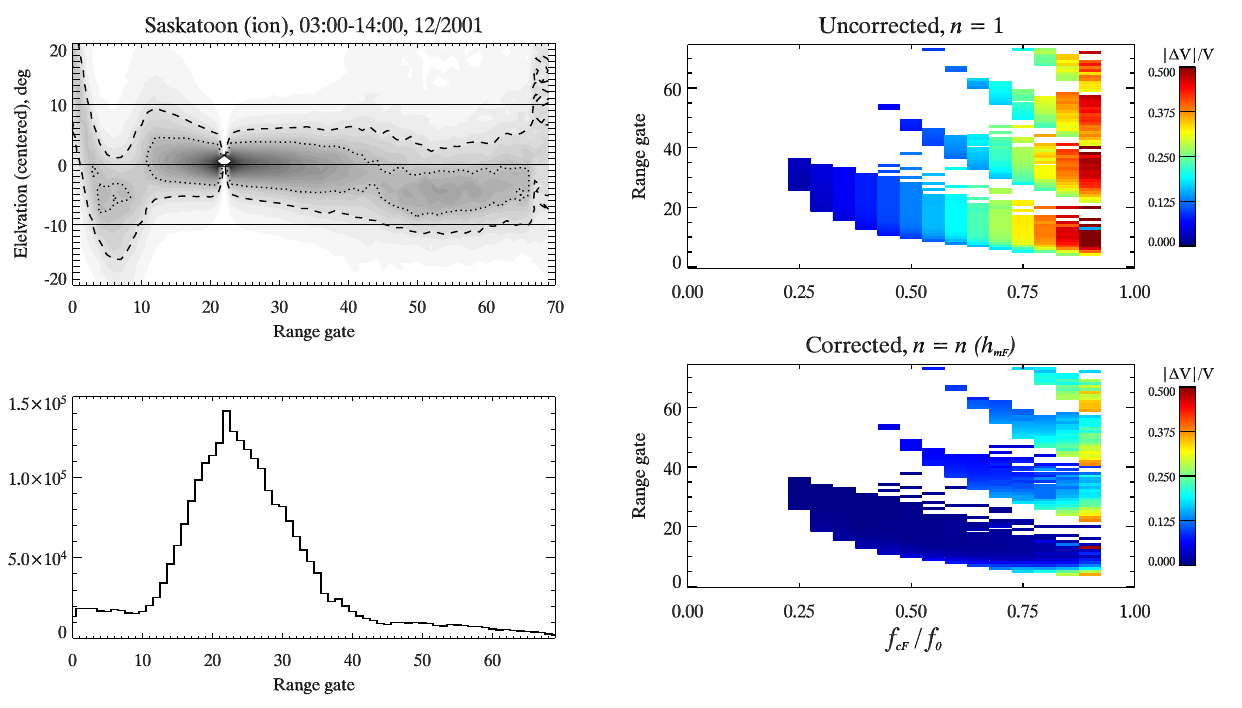
Fig. 11. Elevation histograms presented in the same format as in Fig. 10 except that the elevation data for each beam in each scan were centred on the gate 22 elevation value. This procedure allowed for the removal of ionospheric variability effects from the elevation vs. range dependence (see text for comments).